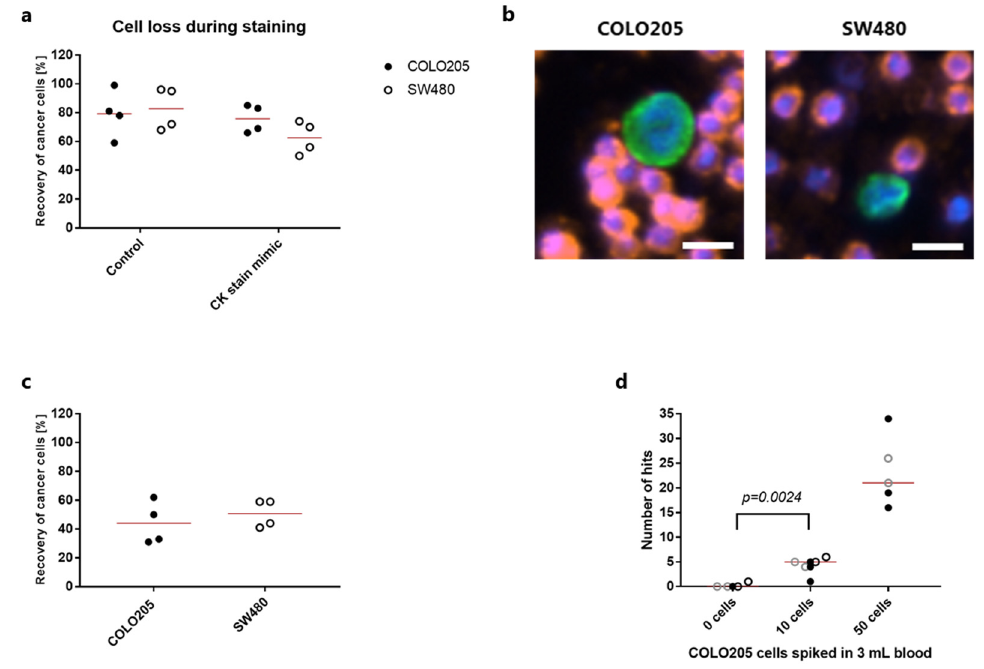
Figure 1. Detection of colorectal cancer cells by rVAR2 capture and immunocytochemistry. ( a ) Recovery (in percentage) of 100 CellTracker pre-stained COLO205 cells (closed circles) or SW480 cells (open circles) after spike-in to 3 mL blood and recovered with rVAR2 through binding to magnetic SeraMag beads. CK stain mimic samples were subjected to a complete staining protocol, but without any antibodies added. Lines represent the mean. ( b ) Representative images of a COLO205 cell (left) and a SW480 cell (right) stained with FITC-labeled anti-Cytokeratin antibody (green). Cell nuclei were stained with DAPI (blue) and white blood cells were stained with PE-conjugated antibodies targeting CD45 and CD66b (red). Scale bar, 10 µm. ( c ) Recovery (in percentage) of 100 COLO205 or SW480 cells after spike-in to 3 mL blood and recovered with rVAR2 through binding to magnetic SeraMag beads. Cancer cells were stained with antibodies as in (b) and identified as CK+, CD45/CD66b-, DAPI+ hits. Lines represent the mean. ( d ). Absolute number of CK+, CD45/CD66b-, DAPI+ hits found after rVAR2 capture from 3 mL blood spiked with 50, 10 or 0 COLO205 cells followed by staining with antibodies as in ( b ). Each type of symbol represents an individual experiment ( n = 3 for 0 and 10 cell spike-in, n = 2 for 50 cell spike-in) always carried out in duplicates or triplicates. Lines represent median. 0 cells vs 10 cells were compared statistically using a Mann-Whitney test.